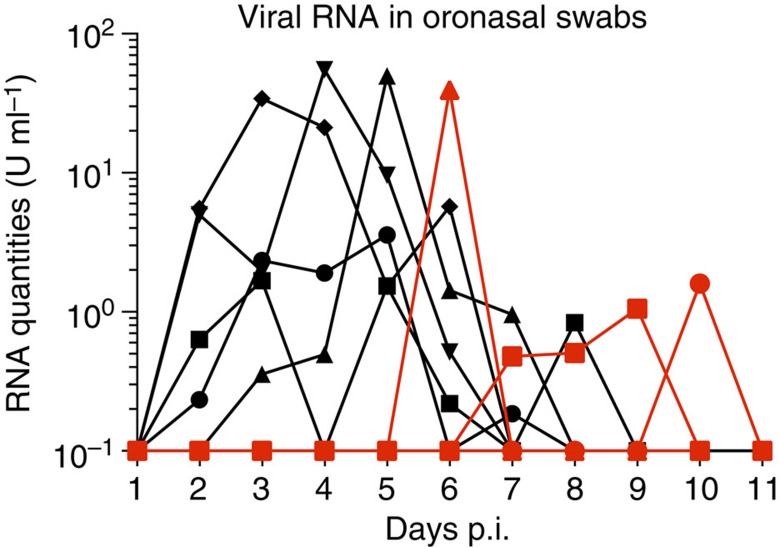
Viral RNA load in oronasal swabs.Oronasal swabs were collected daily from the experiments shown in Fig. 1 (experiment one and two as described in Methods); viral loads were quantified by real-time RT–qPCR (1 U corresponding to the RNA quantity found in 1 TCID50 of a virus stock). Black: needle-infected animals (n=5); red: contact-infected pigs (n=3).